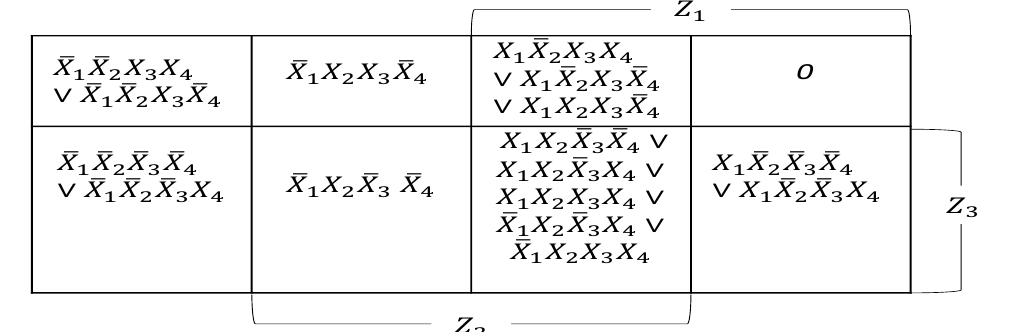
Fig. 20. Final map for both 𝑔(𝑿, 𝒁) and 𝐺(𝑿, 𝒁,